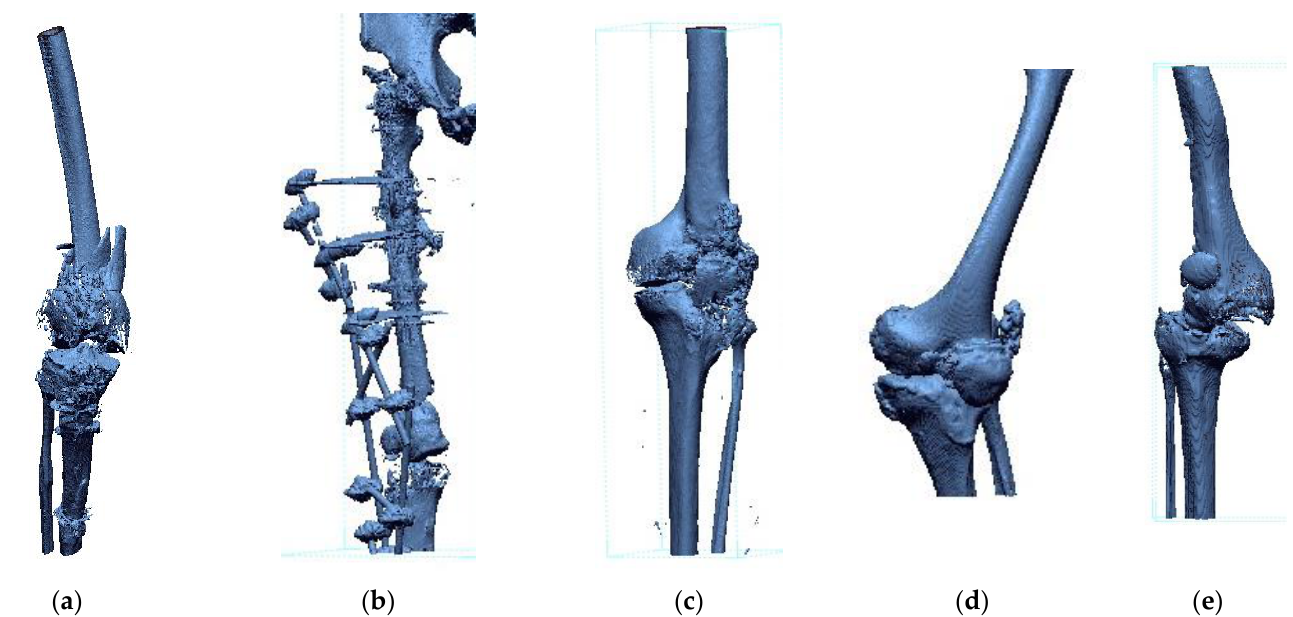
Figure 2. Cases of patients suffering from pathology of the knee joint: ( a ) Patient No. 1; ( b ) Patient No. 2; ( c ) Patient No. 3; ( d ) Patient No. 4; and ( e ) Patient No. 5.